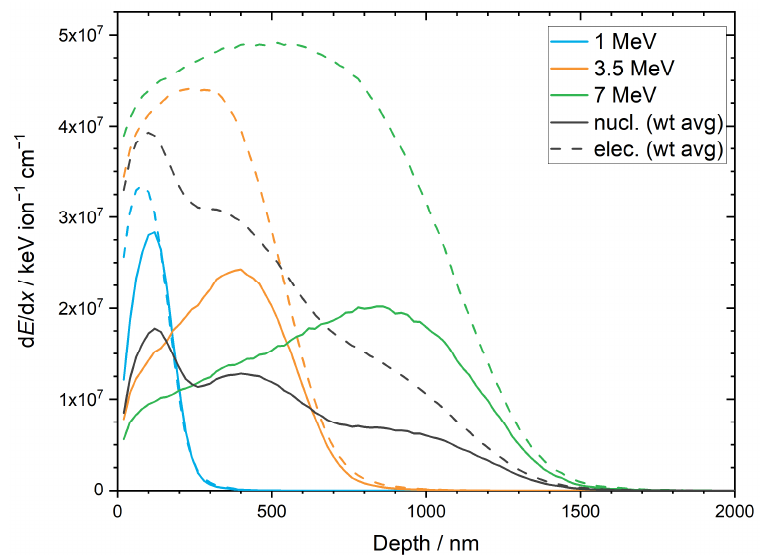
Figure 6. Simulated energy deposition in monazite-structured SmPO 4 by nuclear (continuous lines) and electronic (dashed lines) stopping processes due to irradiation with Au ions of different energies (individual ions and weighted average for triple irradiation).